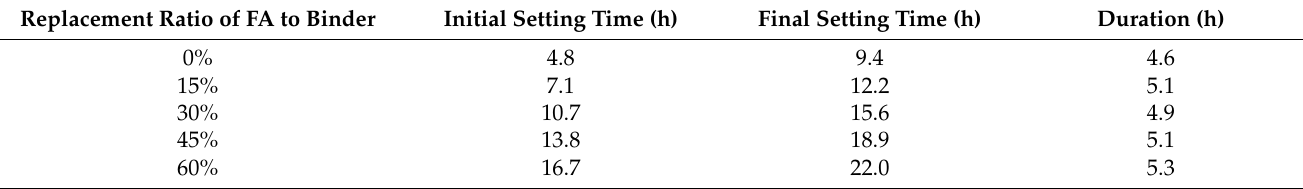
Table 3. Setting times for SCC specimens with different FA replacement ratios predicted by penetra- tion resistance